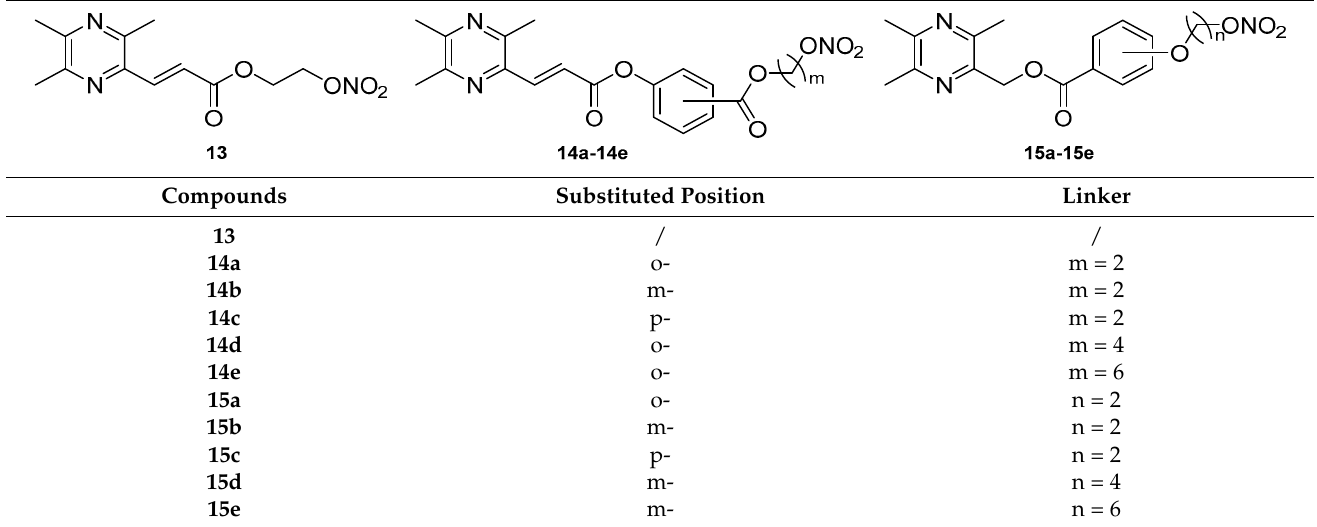
Table 1. Chemical structures of compounds 14a – 14e and 15a – 15e .